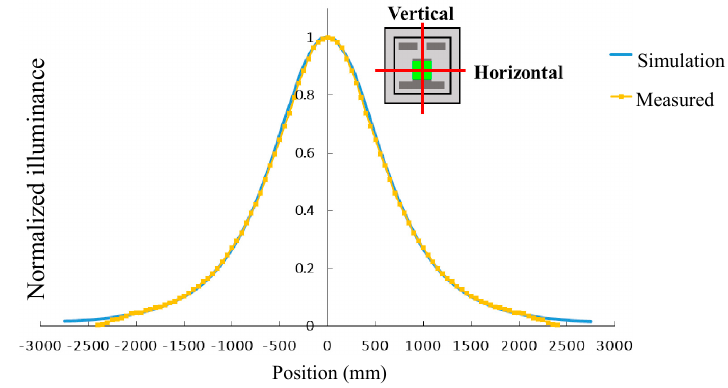
Figure 7. Measured and simulated illuminance distributions.